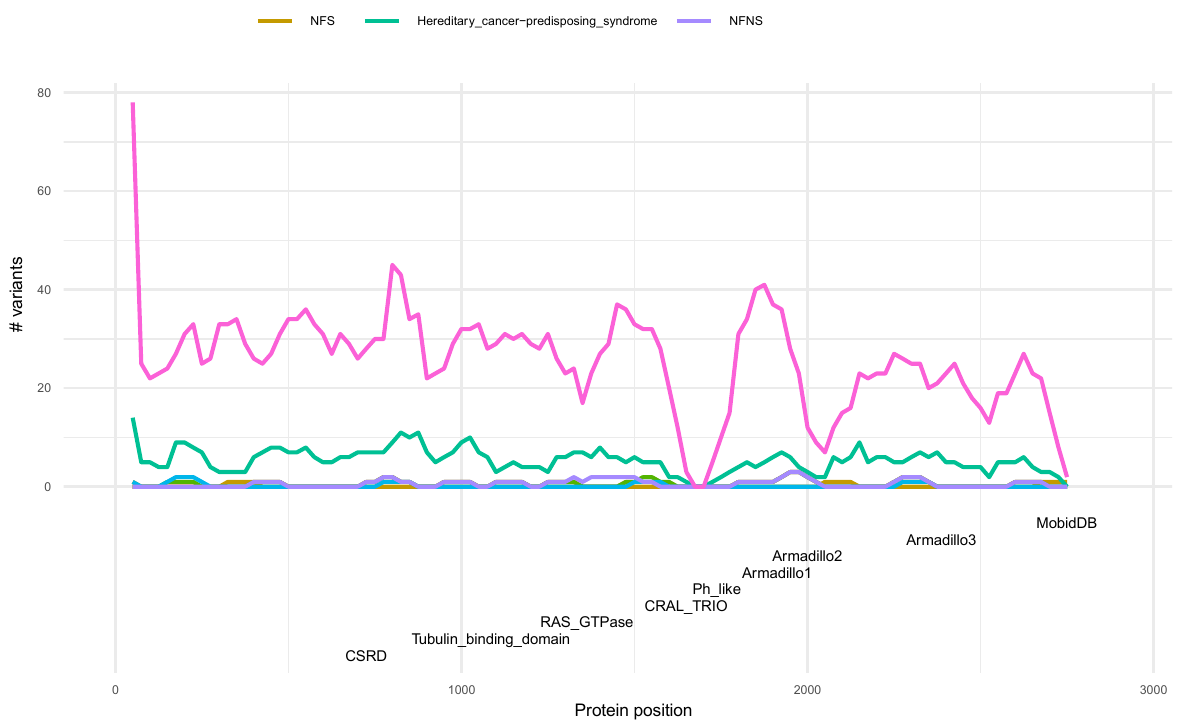
Figure 5. Distribution of phenotypes across neurofibromin based on the sliding window test. The continuous line and colors indicate the distribution of variants according to their phenotype as annotated in ClinVar. Neurofibromin protein domains are defined at the bottom.